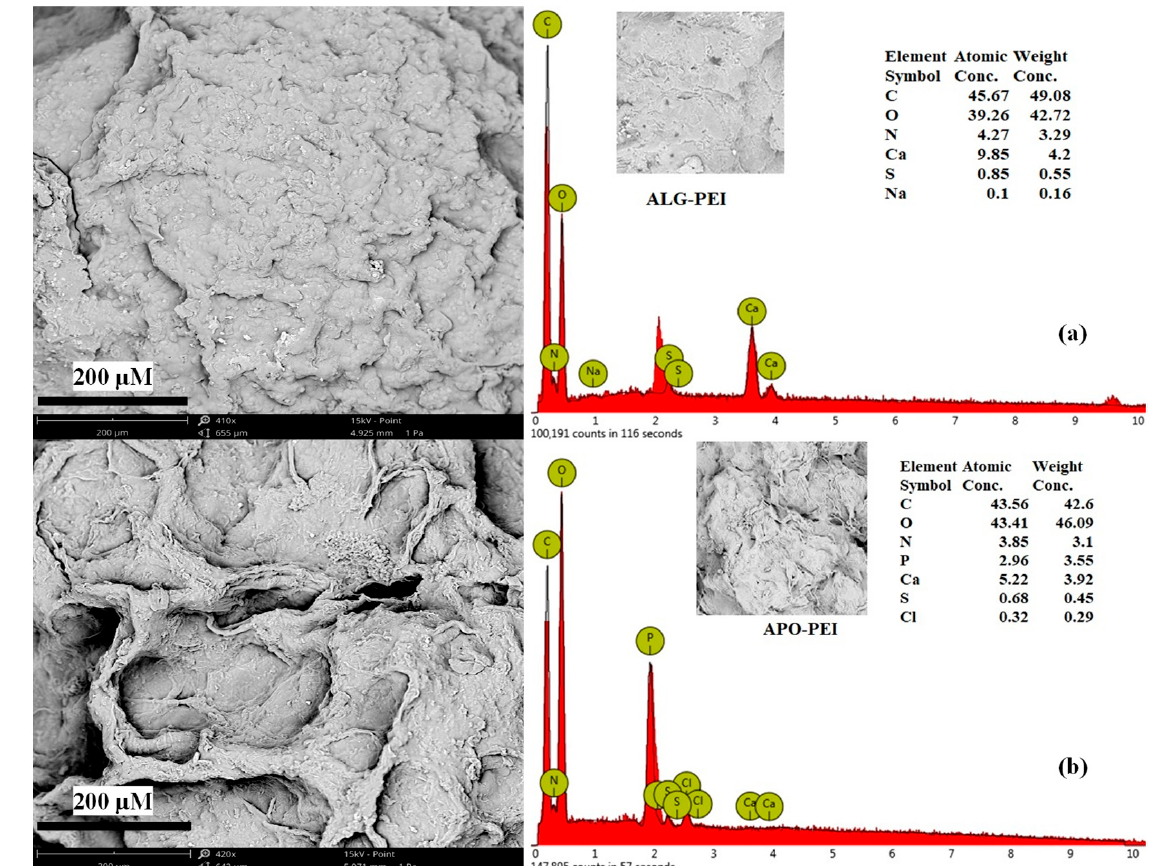
Figure A4. SEM observation ( left panels) and semi-quantitative EDX analysis ( right panels) of ALG-PEI ( a ) and APO-PEI ( b ).